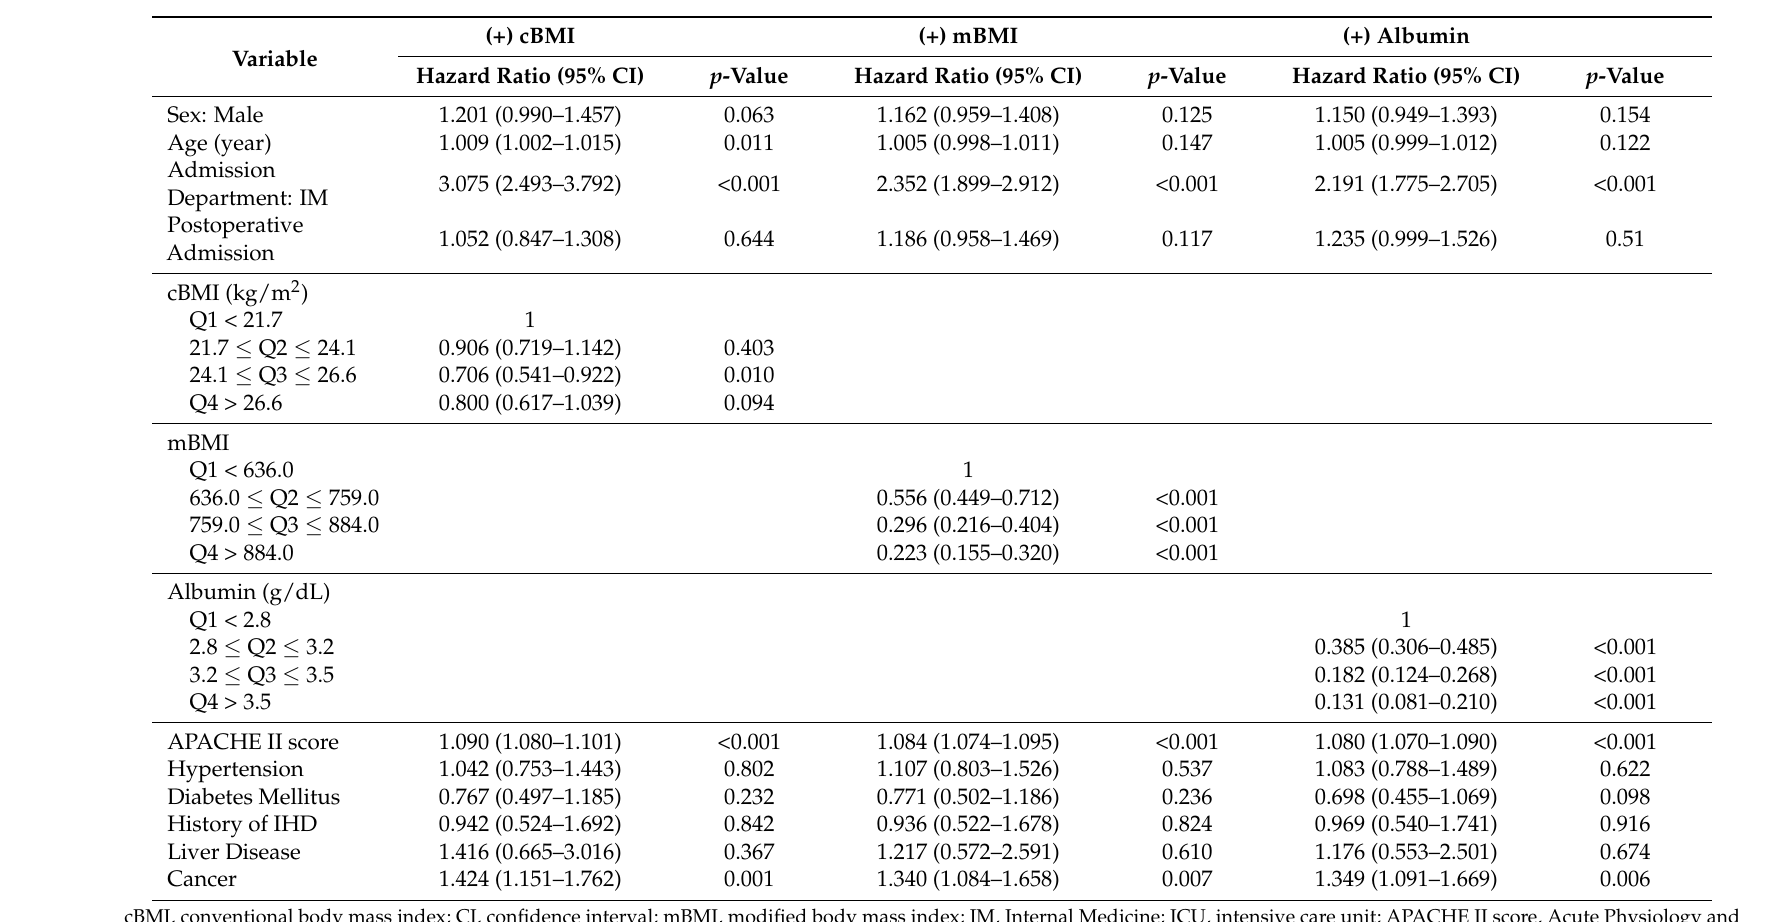
Table 2. Multivariate Cox regression analysis for 30-day mortality after ICU